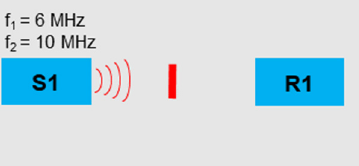
Figure 12. Excitation frequencies: f 1 = 6 MHz, f 2 = 10 MHz.